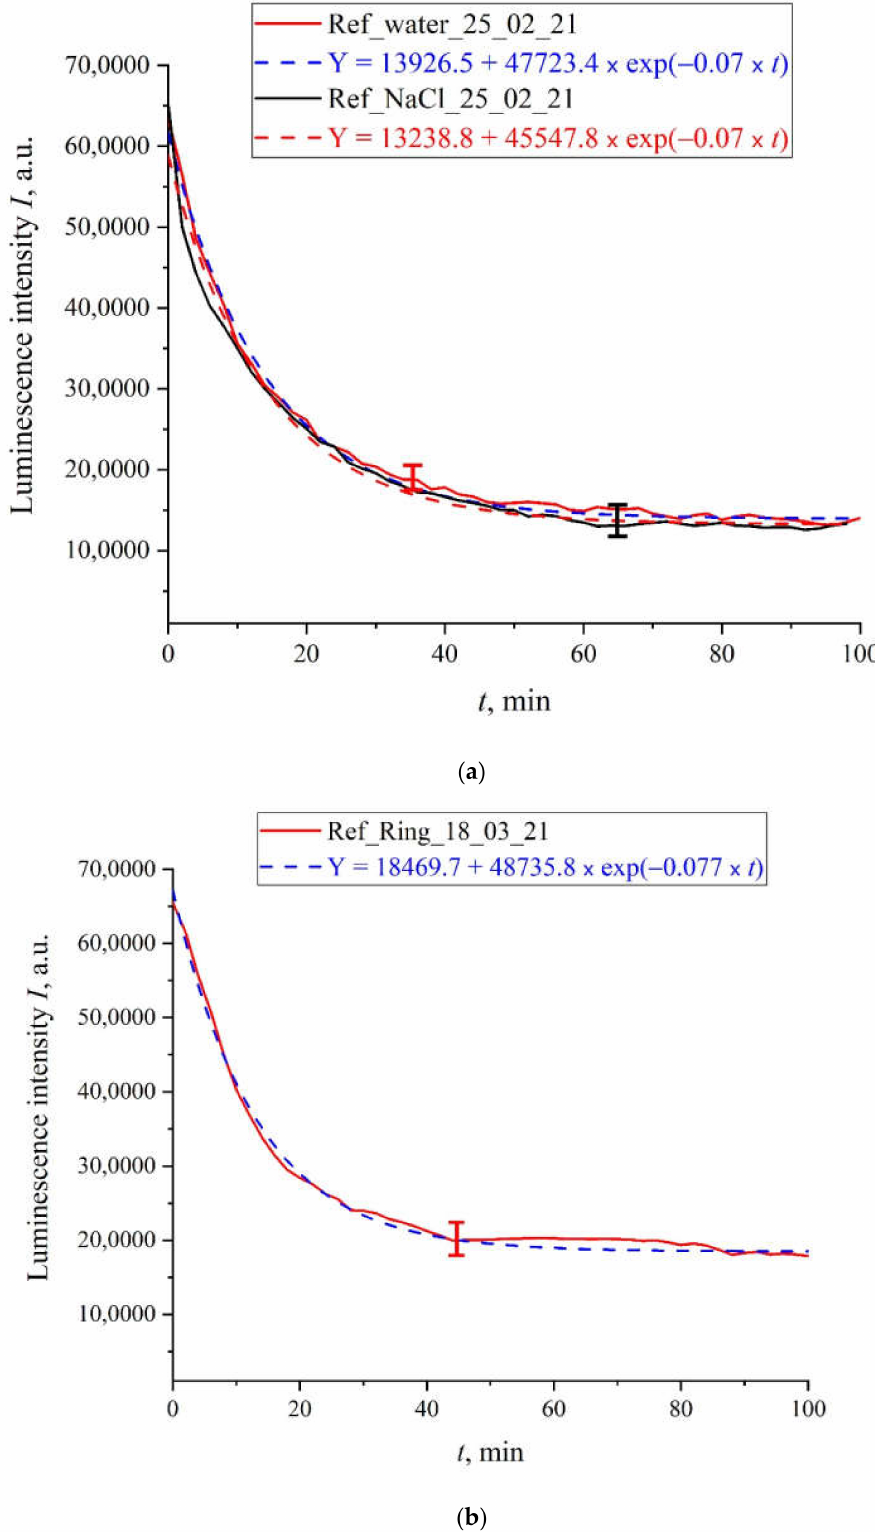
Figure 4. Intensity of luminescence in the spectral maximum vs. the time of soaking of the polymer membrane for untreated solutions (reference samples); ( a )—deionized water; —NaCl solution; ( b )— Ringer’s